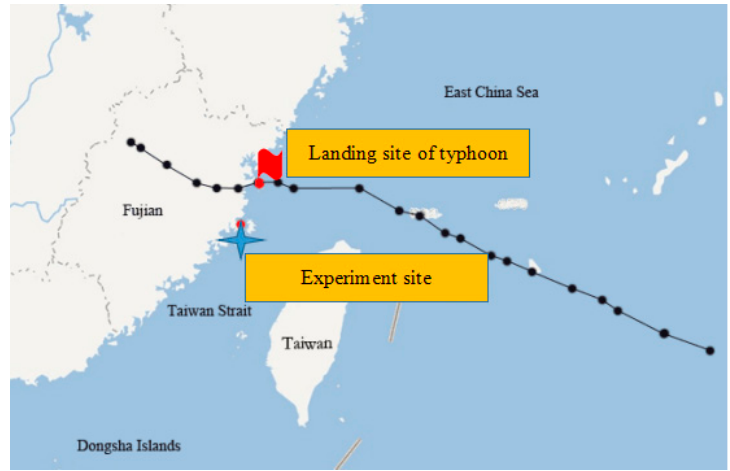
Figure 5. The path of Typhoon “Maria”.